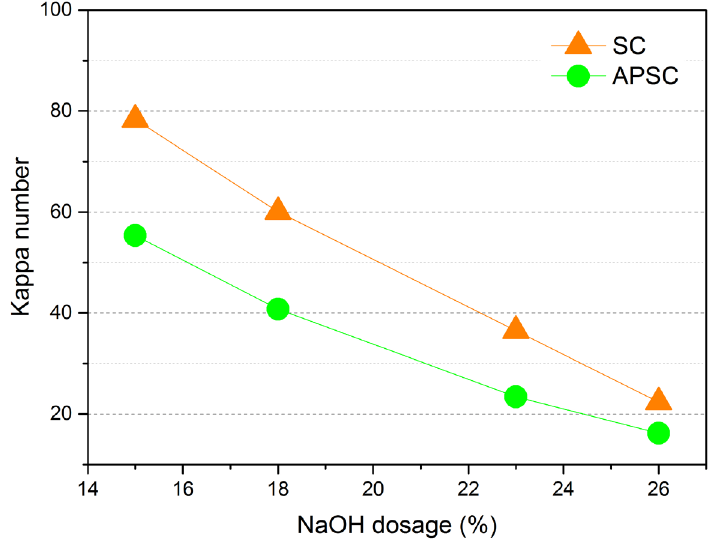
Figure 5. Comparison of Kappa number of screened pulp between SC and APSC at different NaOH dosages.